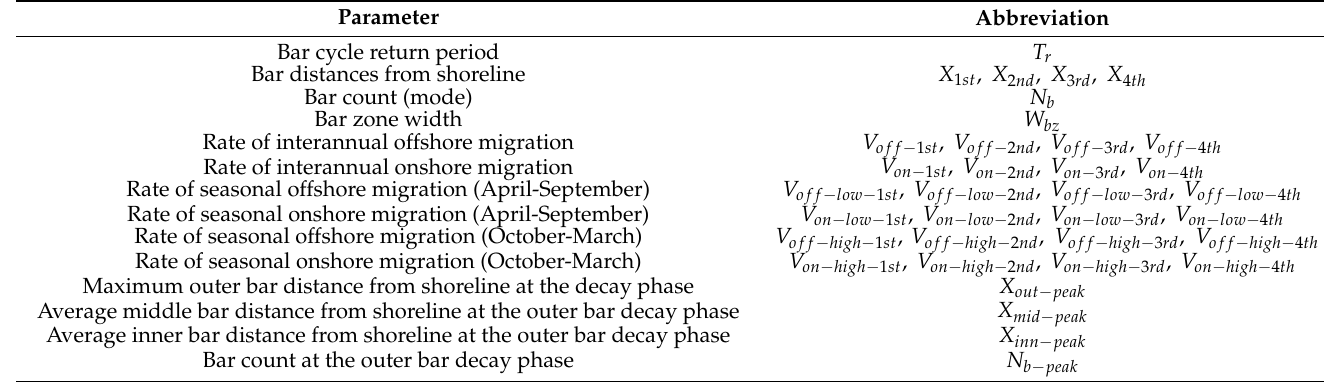
Table 1. The abbreviations for the temporal and morphological parameters of the nearshore bars used in this study. The subscripts 1 st , 2 nd , 3 rd , and 4 th indicate if the parameter applies to the first, second, third, or fourth bar. Offshore and onshore bar migration rates were calculated in metres per month